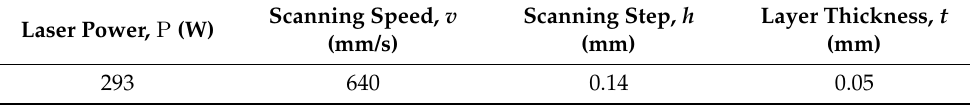
Table 9. Optimal values of technological conditions for LPBF with HN58MBYu. Laser Power, Р